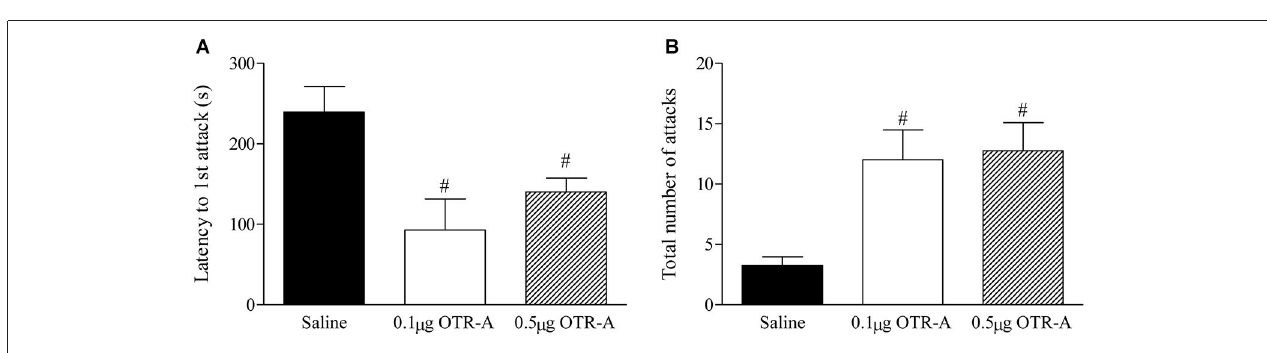
decrease in latency to attack the intruder (A) and a greater number of total intruder attacks (B) as compared to saline controls. Bars represent mean ± SEM; # P < 0.05 0.1 µ g/ µ l OTR-A and 0.5 µ g/ µ l OTR-A vs. saline.